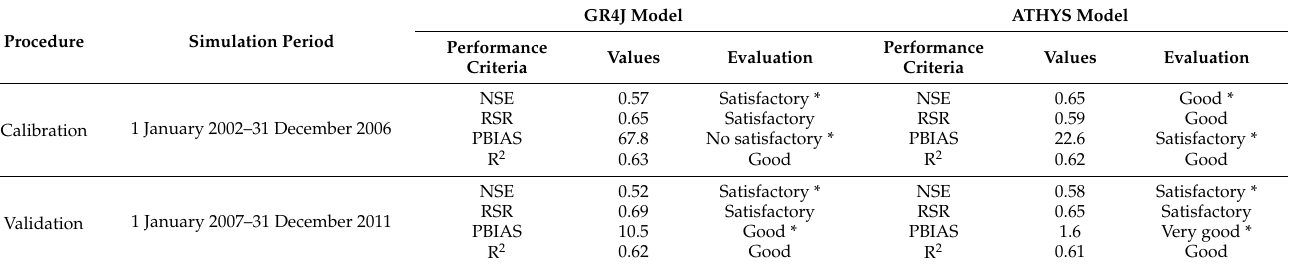
Table 2. Performance comparison of the results of two hydrological models used (GR4J and